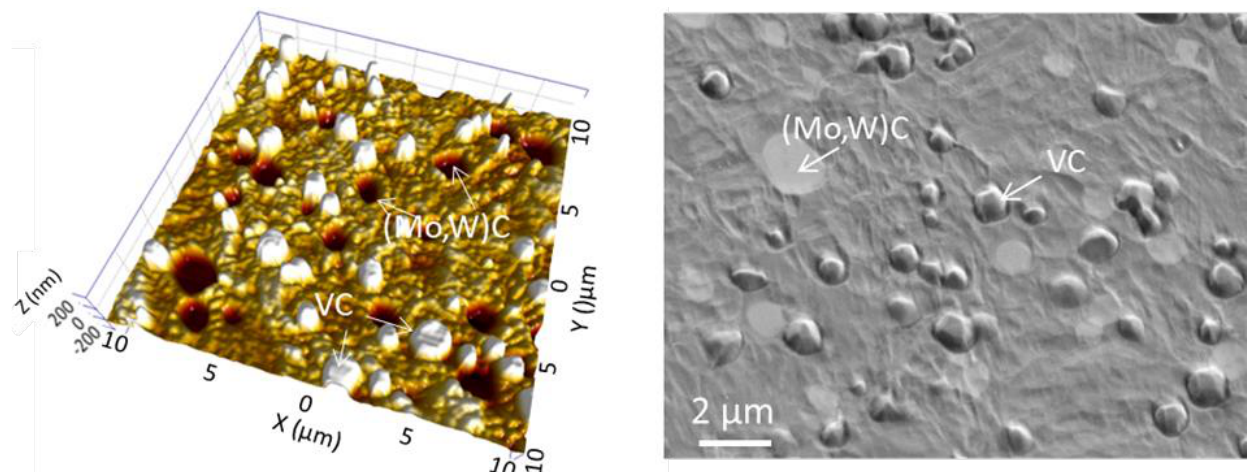
Figure 13. AFM and SEM images of the shallow protrusions and shallow craters formed by the RF ion etching of ASP30 tool steel substrate in the CC7 deposition system. The SEM image is a side view from about 45° inclined direction. Carbide inclusions do not retain their original profiles; they develop facets on the sidewalls and trenches at the bottom. The VC carbides become more protruding from the matrix and sharper after longer etching times.